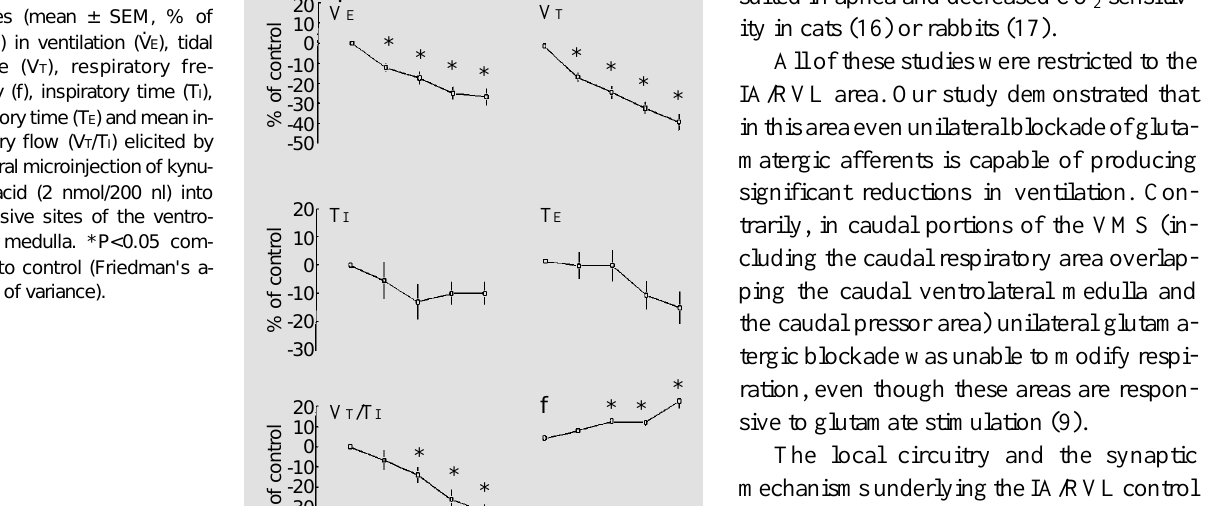
Figure 2 - Time course of changes (mean ± SEM, % of (V. control) in ventilation E ), tidal volume (V T ), respiratory fre- quency (f), inspiratory time (T I ), expiratory time (T E ) and mean in- spiratory flow (V T /T I ) elicited by unilateral microinjection of kynu- renic acid (2 nmol/200 nl) into responsive sites of the ventro- lateral medulla. *P<0.05 com- pared to control (Friedman's a- nalysis of